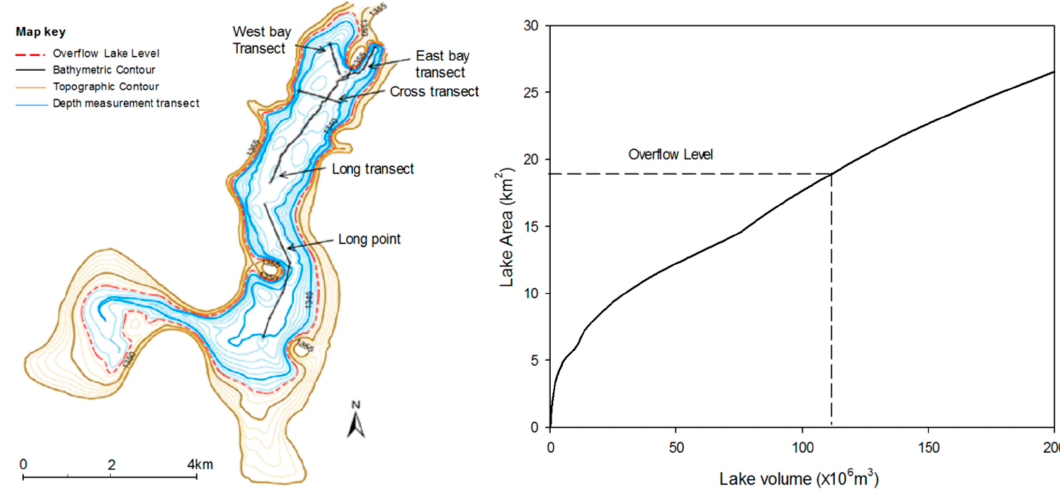
Figure 4. Lake Babati bathymetry ( left ) and area–volume relationship ( right ).